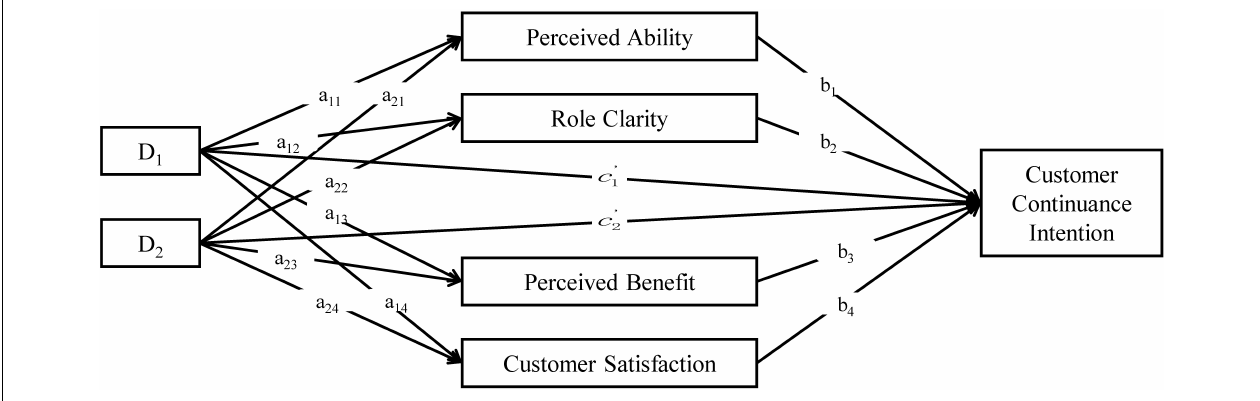
FIGURE 2 | Indirect effects on customer continuance